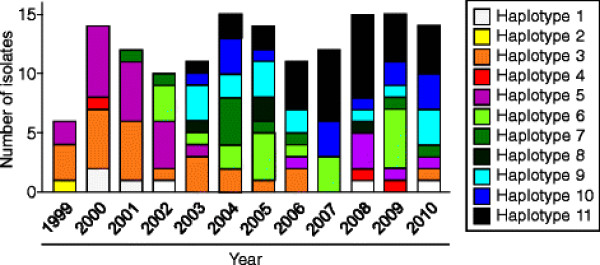
Annual distribution of PvMSP-142 haplotypes during the study period. The 149 PvMSP-142 sequences from Korean isolates were analysed by year of collection. Only Belem type haplotypes of PvMSP-142 were identified during 1999–2000. Recombinant types began to be identified in 2001, and both Belem-type and recombinant type haplotypes were identified thereafter.